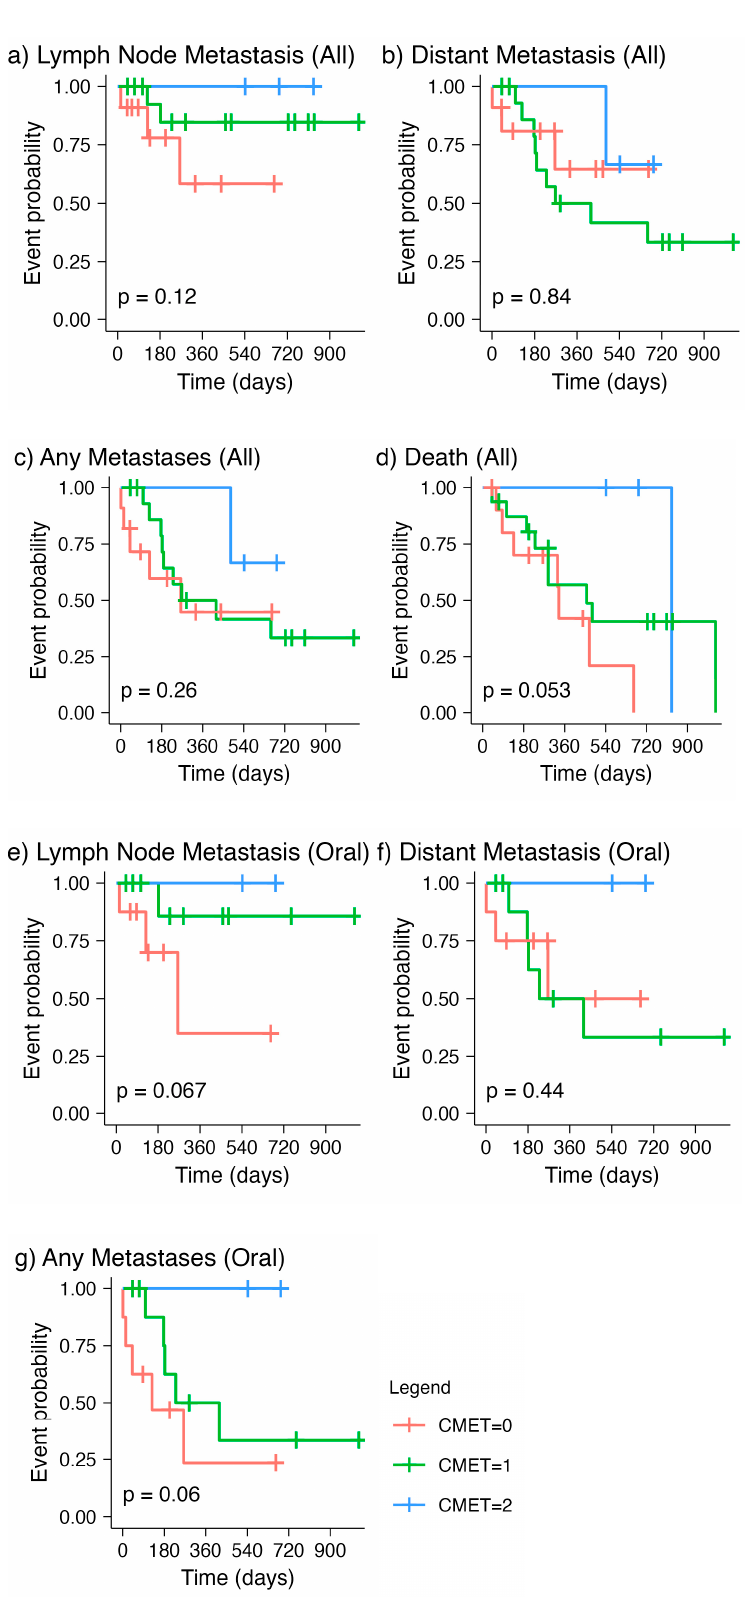
Figure 2. Kaplan–Meier curves by Met scores for time to ( a ) lymph node metastasis, ( b ) distant metastasis, ( c ) any metastases, ( d ) death for all canine melanomas, and for time to ( e ) lymph node metastasis, ( f ) distant metastasis, and ( g ) any metastases for canine oral